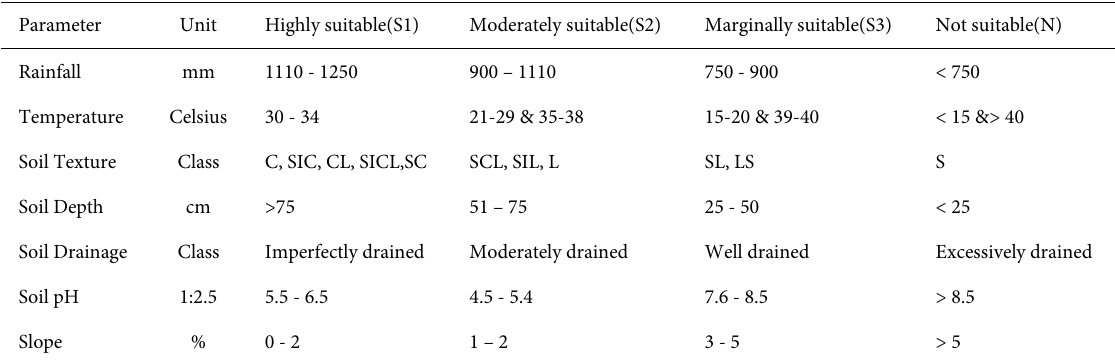
Table 2: Suitability criteria for rice (NBSS and LUP) (Naidu et al.,